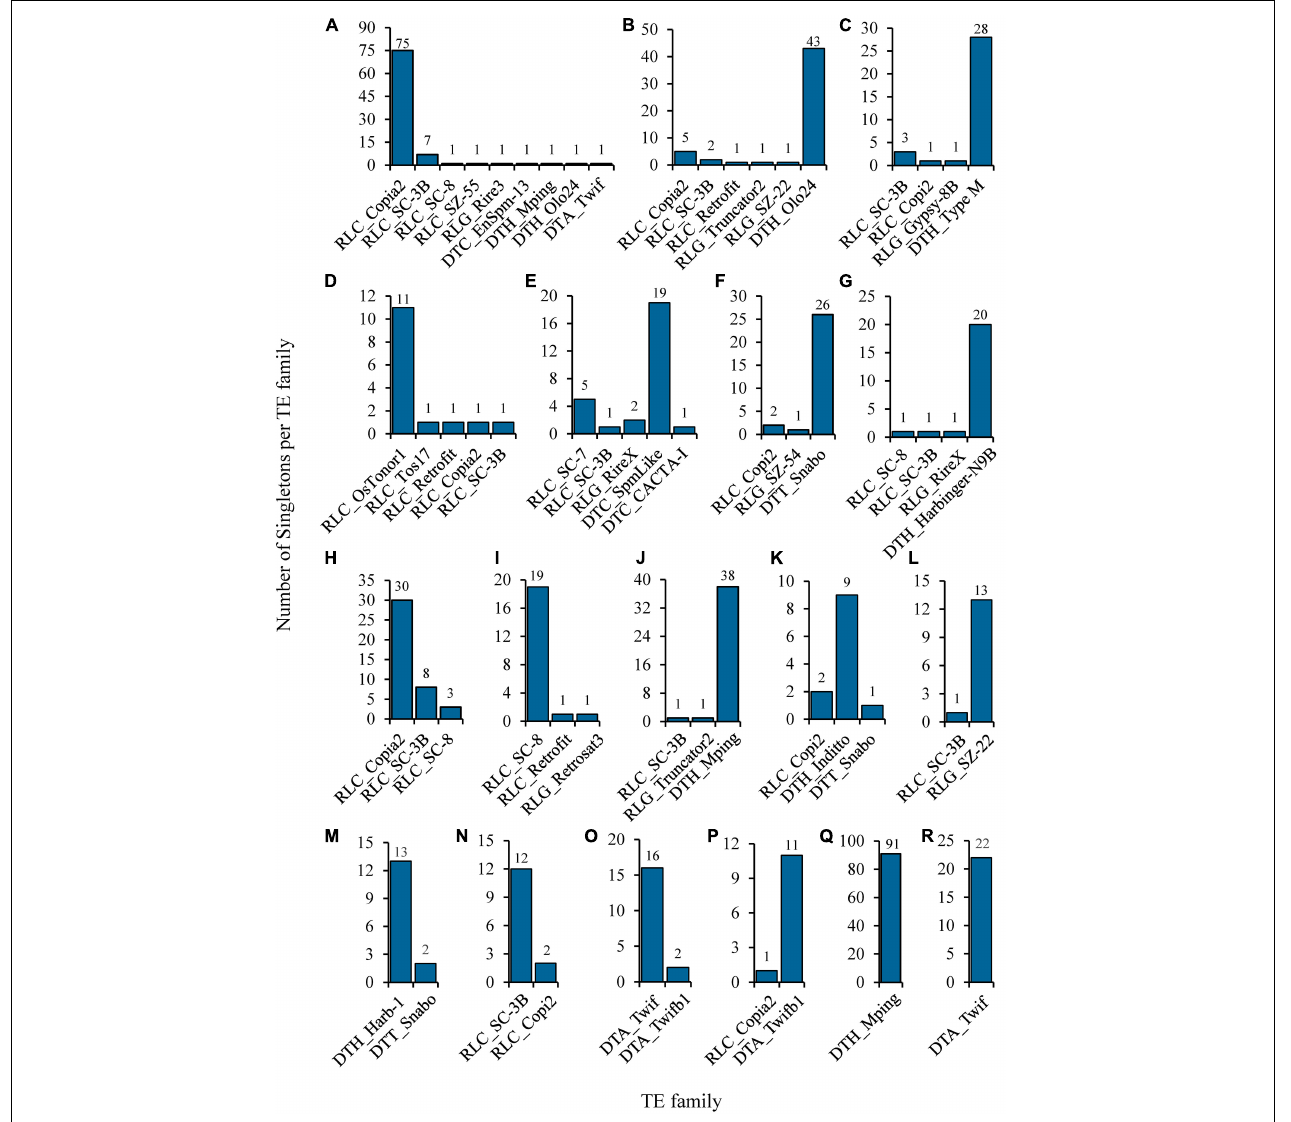
FIGURE 4 | Selected examples of potentially highly-active TEs identified from natural rice accessions. The histograms show the composition of singletons identified in each of the following rice accessions: (A) Trop/IRIS_313-7885; (B) Trop/IRIS_313-10703; (C) indx/IRIS_313-12300; (D) Subtrop/IRIS_313-11897; (E) aus/IRIS_313-11482; (F) Ind2/IRIS_313-9740; (G) aus1/IRIS_313-10930; (H) Trop/IRIS_313-10758; (I) Aro/IRIS_313-11068; (J) Temp/IRIS_313-11655; (K) ind3/IRIS_313-12142; (L) Subtrop/IRIS_313-8580; (M) ind2/IRIS_313-8703; (N) Indx/B090; (O) Temp/IRIS_313-11800; (P) Trop/IRIS_313-9550; (Q) Temp/IRIS_313-15904; (R) Temp/IRIS_313-8149. The three-letter prefix in the TE family name represents the superfamily to which it belongs. Its meaning is as follows: RLC: Copia; RLG: Gypsy; DTC: EnSpm/CACTA; DTH: PIF/Harbinger; DTA: hAT; DTT: